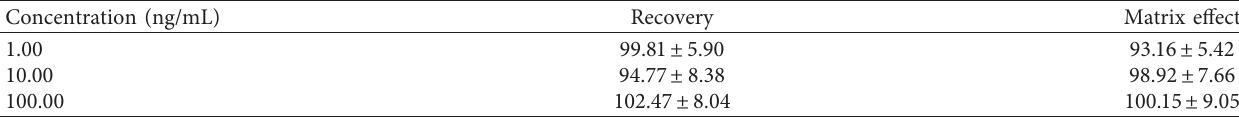
Table 3: Recovery and matrix effect of TMEA (%, n � 6).